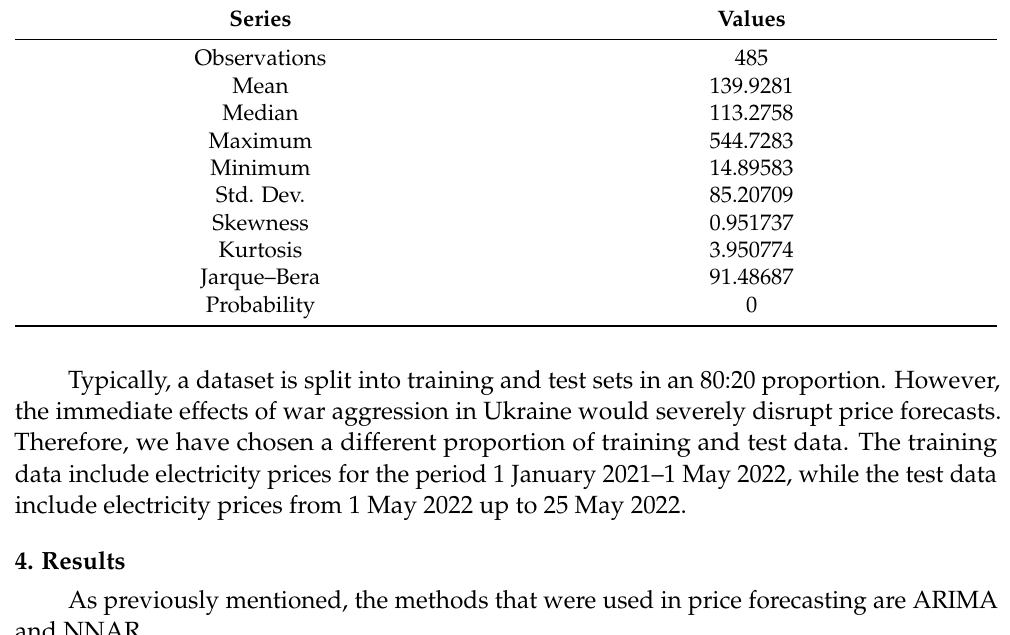
Table 2. Descriptive statistics of analyzed prices.